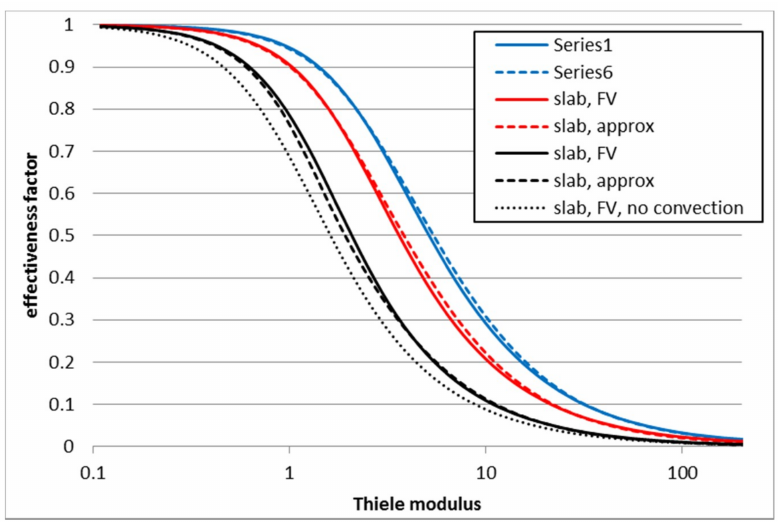
Figure 6. Effectiveness factors for second order elementary reaction A + B → C with non-stoichiometric feed in three geometries with finite volume and approximate method. Effectiveness factors for slab when convective flux is neglected is shown for